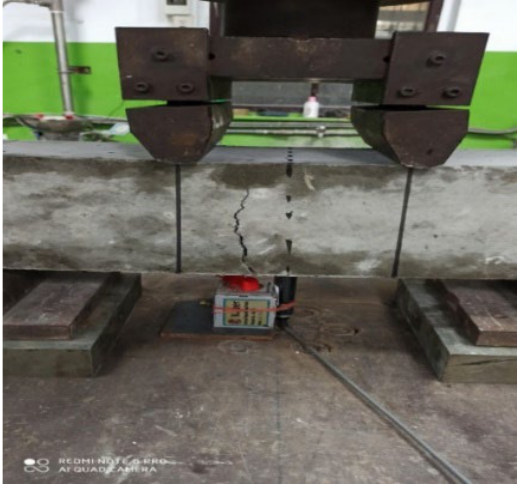
Figure 7. Flexural test of beam specimen (four-point